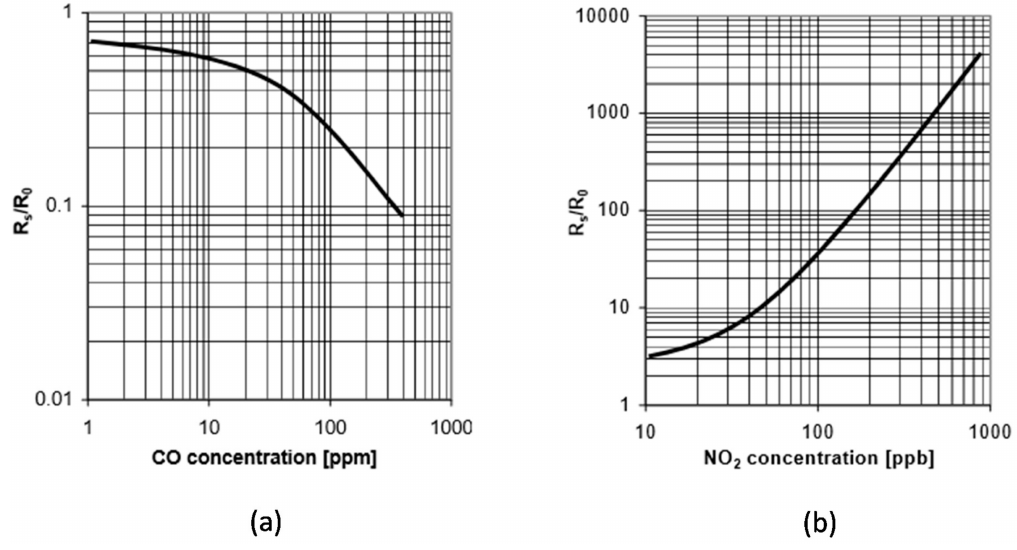
Figure 7. MiCS-4514 calibration curves: ( a ) CO concentration; ( b ) NO 2 concentration [30].